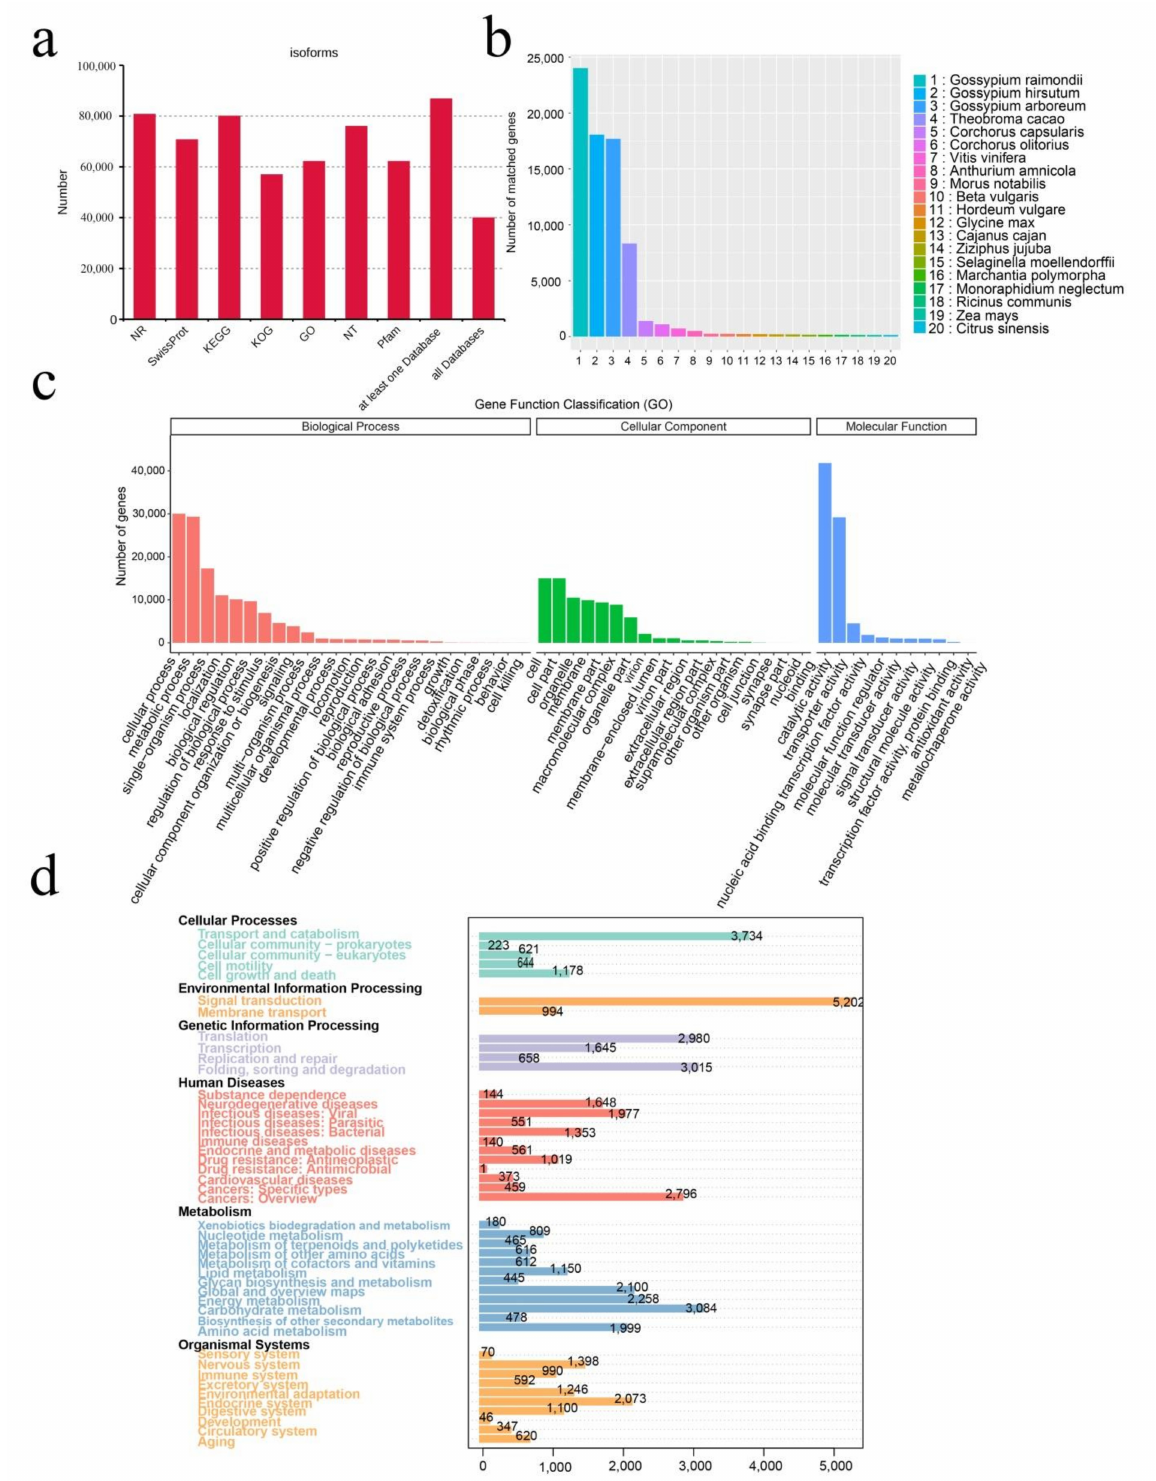
Figure 1. Iso-seq, assembly, and annotation of H. hamabo. ( a ) Statistical graph of the annotation results from seven databases. ( b ) The distribution of homologous species annotated in the NCBI non- redundant protein (NR) database and lengths of transcripts. ( c ) Gene Ontology (GO) classification of the assembled full-length transcripts. ( d ) Kyoto Encyclopedia of Genes and Genomes (KEGG) annotation of the assembled full-length